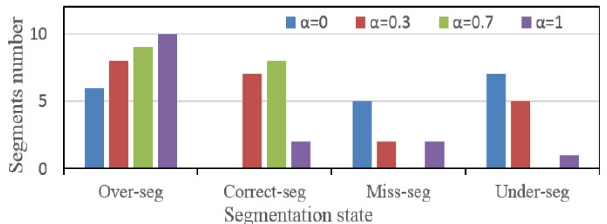
Figure 6. Segmentation results with different combination weighting values for scene 3.